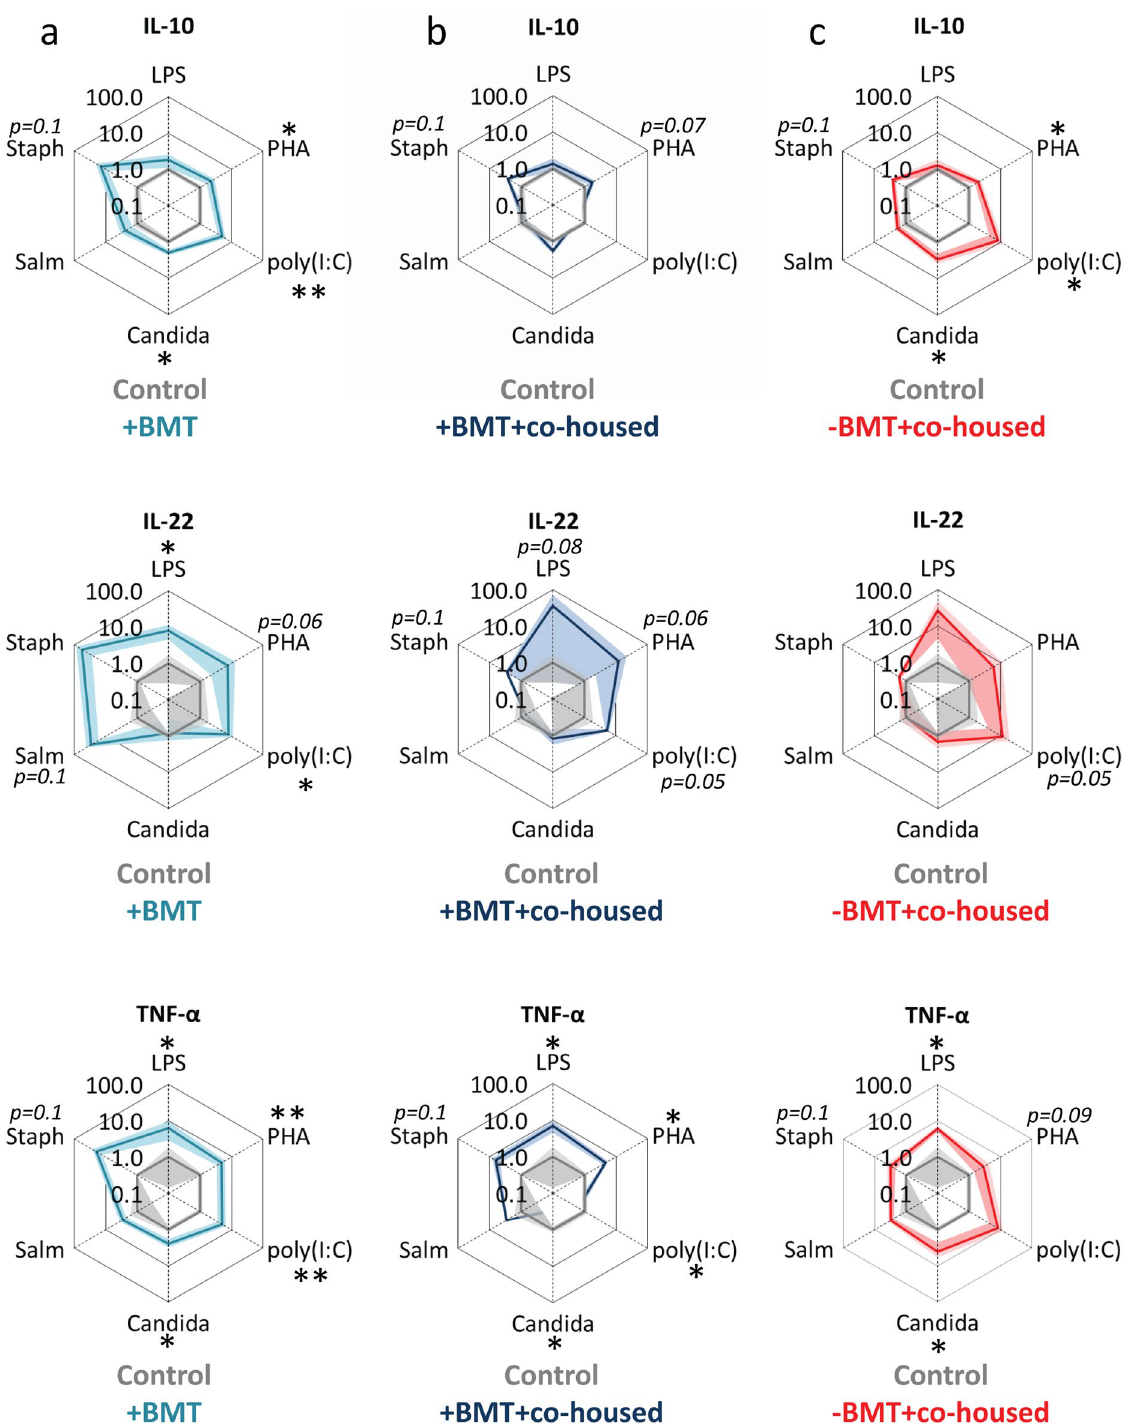
Figure 3. The effect of cecum content transfer after BMT on cytokine secretion of stimulated splenocytes. Spiderplots show IL-10, IL-22 and TNF-α release in response to various pathogenic stimuli from splenocytes derived from ( a ) germfree mice inoculated with cecum content samples of BMT-treated mice co-housed with BMT-mice (outer light blue lines), ( b ) germfree mice inoculated with cecum content samples of BMT-treated mice co-housed with control mice (outer dark blue lines), and ( c ) germfree mice inoculated with cecum content samples of control mice co-housed with BMT mice (outer red lines). Cytokine concentrations in response to stimuli are normalized to the cytokine concentrations of splenocytes from germfree mice inoculated with cecum content samples of control mice co-housed with control mice (inner grey lines). See legend to Fig. 1 for more information. Groups were compared using Mann–Whitney U test; n = 3–5; *p <